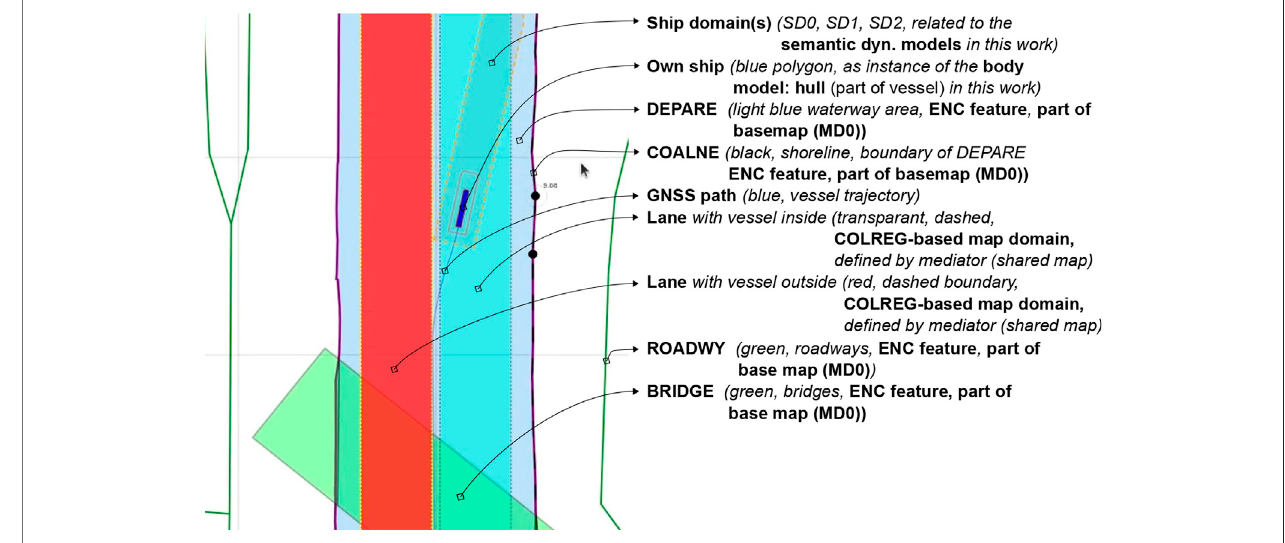
FIGURE 7 | General legend for map features depicted throughout this paper.